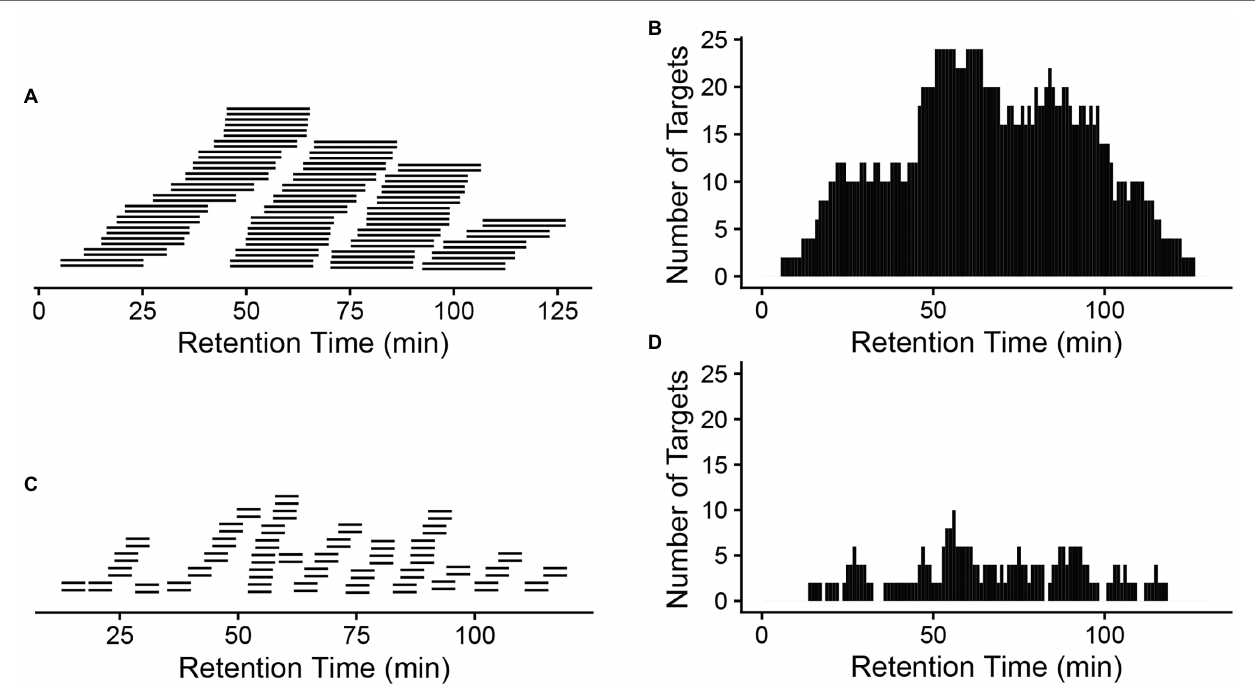
FIGURE 2 | A narrow window is preferred to reduce monitored targets at a given time. A 20-min window (A) will result in a longer target list (B) that will be monitored at a given time than a 5-min window (C,D) . x -axis: retention time (gradient). A total of 42 peptide pairs (light and heavy) are in the targeted list across the whole gradient (A,C) . More monitored targets in (B) will result in a longer cycle time (the time to cycle through the entire list of the target peptides at a given time on the gradient), meaning longer time between data points for a given peptide, so fewer measurements across the elution of the